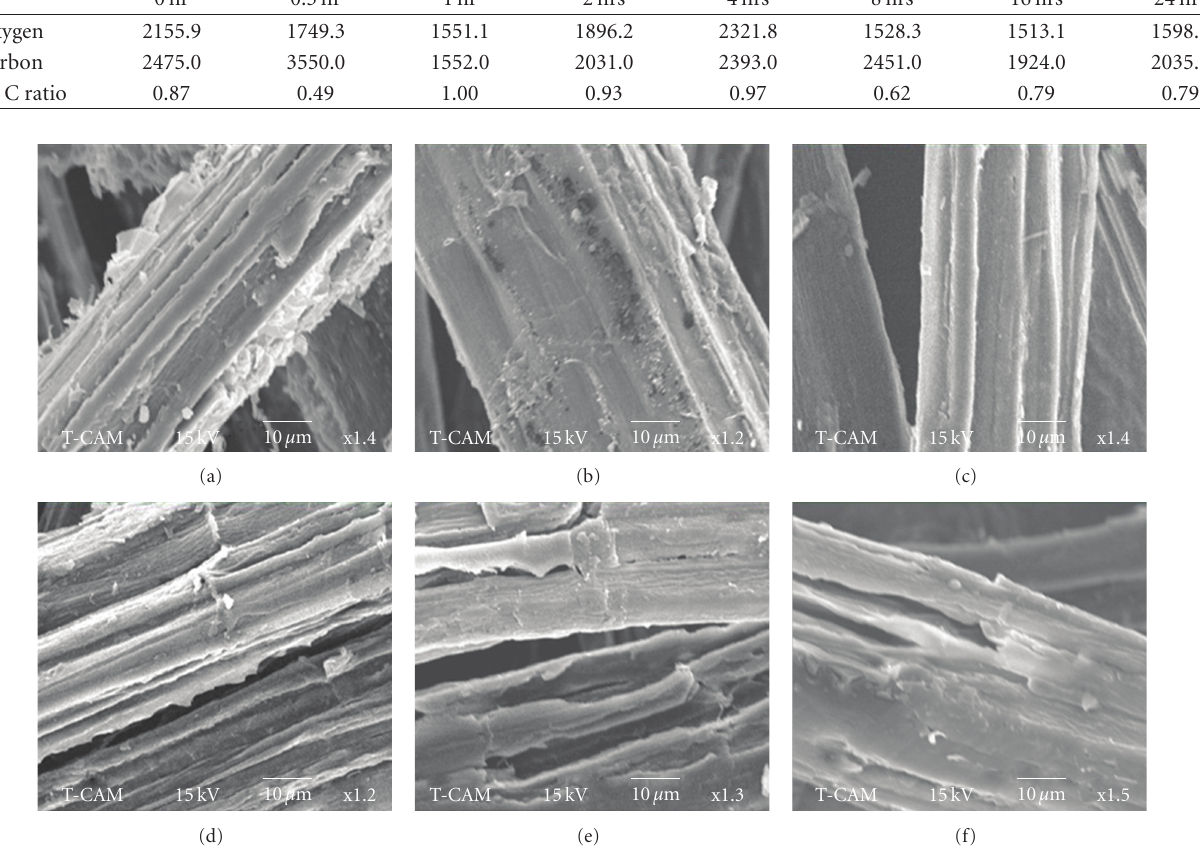
Figure 10: SEM of kenaf fibril bundles for (a) untreated fibers and kenaf fibril bundles treated for (b) 30 minutes, (c) 2 hours, (d) 4 hours, (e) 16 hours, and (f) 24